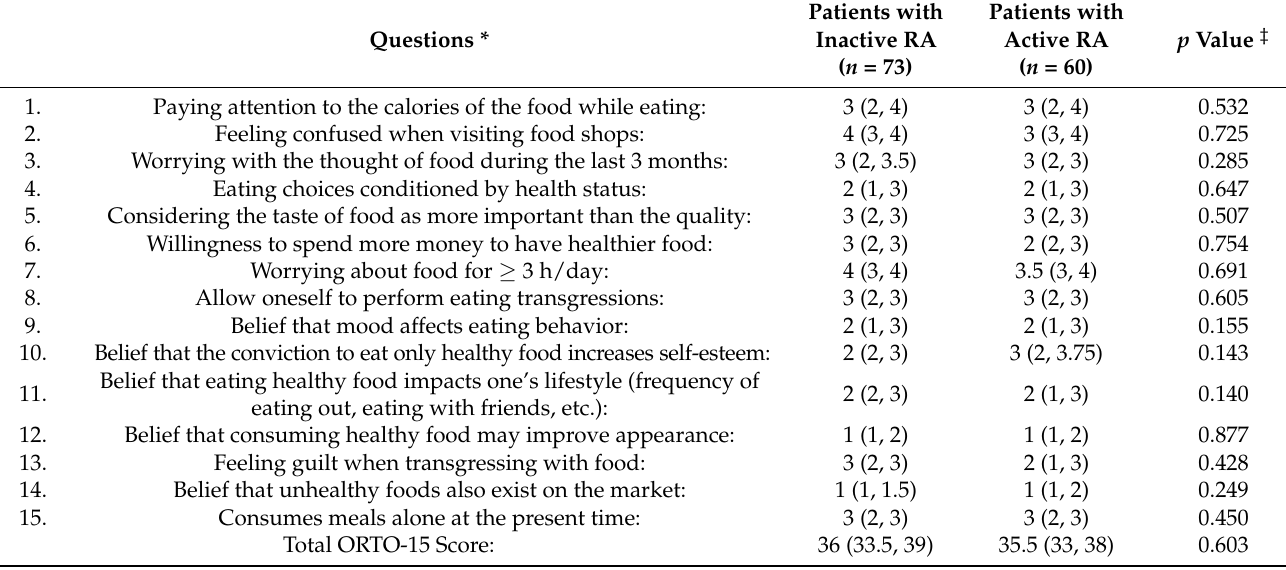
Table 2. Answers to each of the individual questions of the ORTO-15 questionnaire [28,29] † .